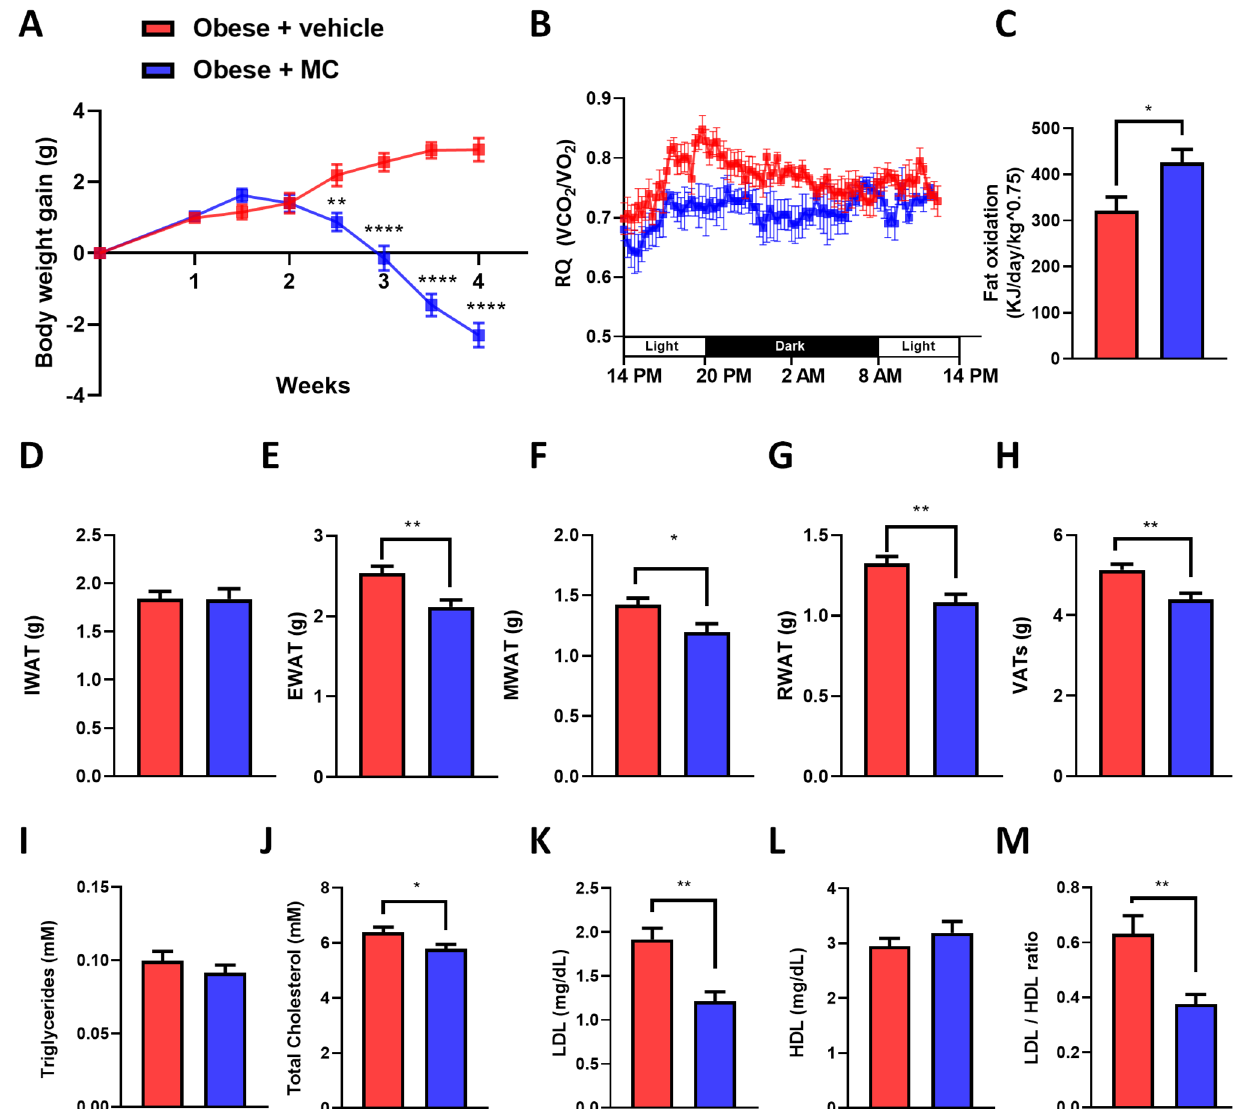
Figure 1. Obese mice supplemented with MC had reduced body weight and smaller visceral WAT depots with an improved biochemical profile. Effects of MC treatment on: ( A ) body weight gain; ( B ) RQ for 24 h; ( C ) fat oxidation. Weights of different adipose tissue depots: ( D ) inguinal (IWAT); ( E ) epididymal (EWAT); ( F ) mesenchymal (MWAT); ( G ) retroperitoneal (RWAT). ( H ) weight of VATs (EWAT + MWAT + RWAT). Serum biochemical parameters of: ( I ) triglycerides; ( J ) total cholesterol; ( K ) LDL-cholesterol; ( L ) HDL-cholesterol; and ( M ) LDL/HDL ratio. Data are mean ± SEM. * p < 0.05, ** p < 0.01, **** p < 0.0001.